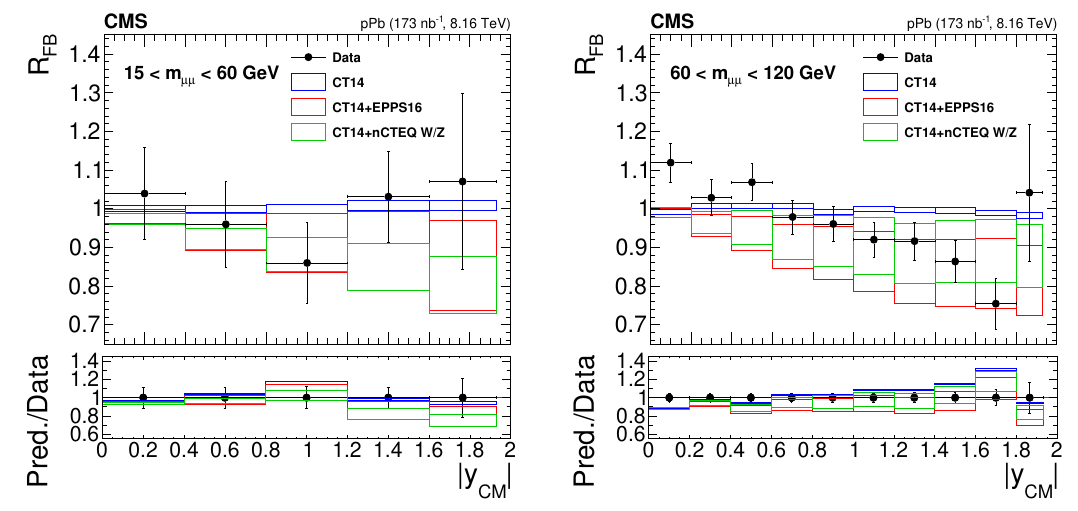
Figure 9 . Forward-backward ratios for 15 < m < 60 GeV (left) and 60 < m < 120 GeV mm mm (right). The error bars on the data points represent the quadratic sum of the statistical and systematic uncertainties. The theory predictions from the powheg NLO generator are also shown, using CT14 [51] (blue), CT14+EPPS16 [14] (red), or CT14+nCTEQ15WZ [19] (green) PDF sets. The boxes show the 68% confidence level (n)PDF uncertainty in these predictions. The ratios of predictions over data are shown in the lower panels, where the data and the (n)PDF uncertainties are shown separately, as error bars around one and as coloured boxes,